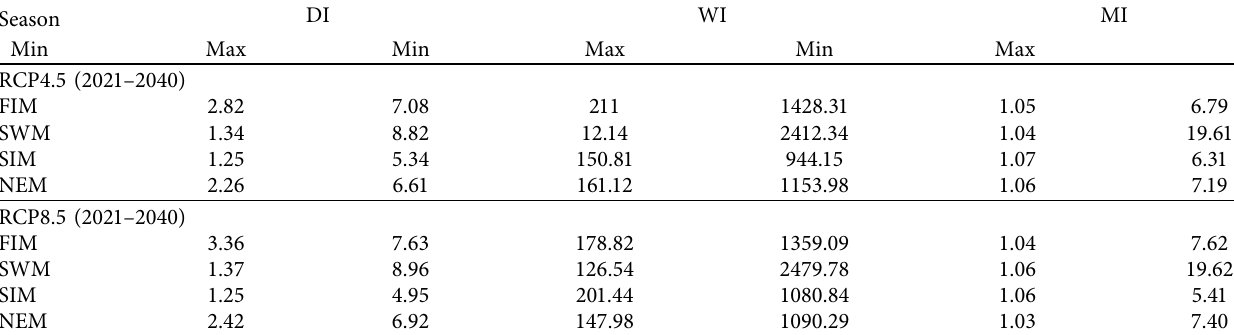
Figure 4: Near-future indices under RCP8.5 (2021–2040). (a) For normalized DI. (b) For normalized WI. (c) Moisture index. Table 3: Minimum and maximum indices for near-future